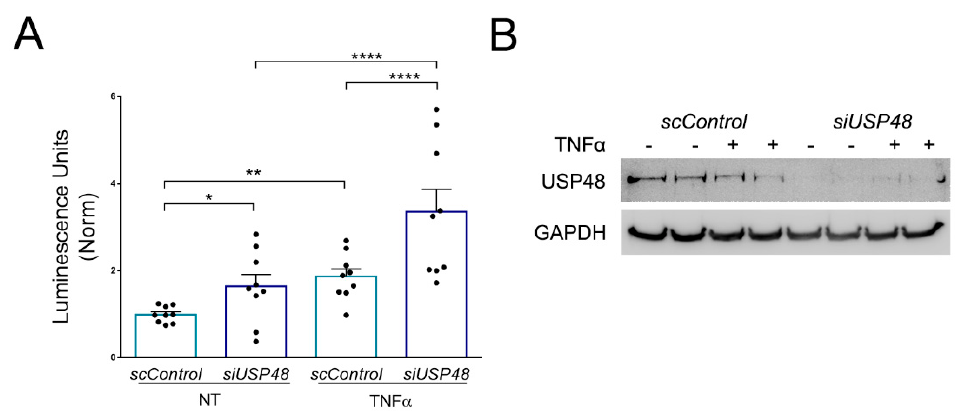
Figure 5. USP48 silencing enhances NF- κ B activity. ( A ) hTERT-RPE1 cells were transfected with scControl or siUSP48, in combination with a 3-kB-luciferase reporter plasmid (Igk-BLuc). Twenty-four hours after transfection, cells were stimulated for 4 h with TNF α and then lysed to measure NF- κ B activity. n = 9 from three independent experiments conducted in triplicate. Data are represented for each experiment as normalized mean ± S.E. Statistical analysis by two-way ANOVA: * p -value ≥ 0.05; ** p -value ≥ 0.01; **** p -value ≥ 0.0001. ( B ) USP48 expression was efficiently silenced by siUSP48 (representative western blot). Tubulin was used as a loading control.